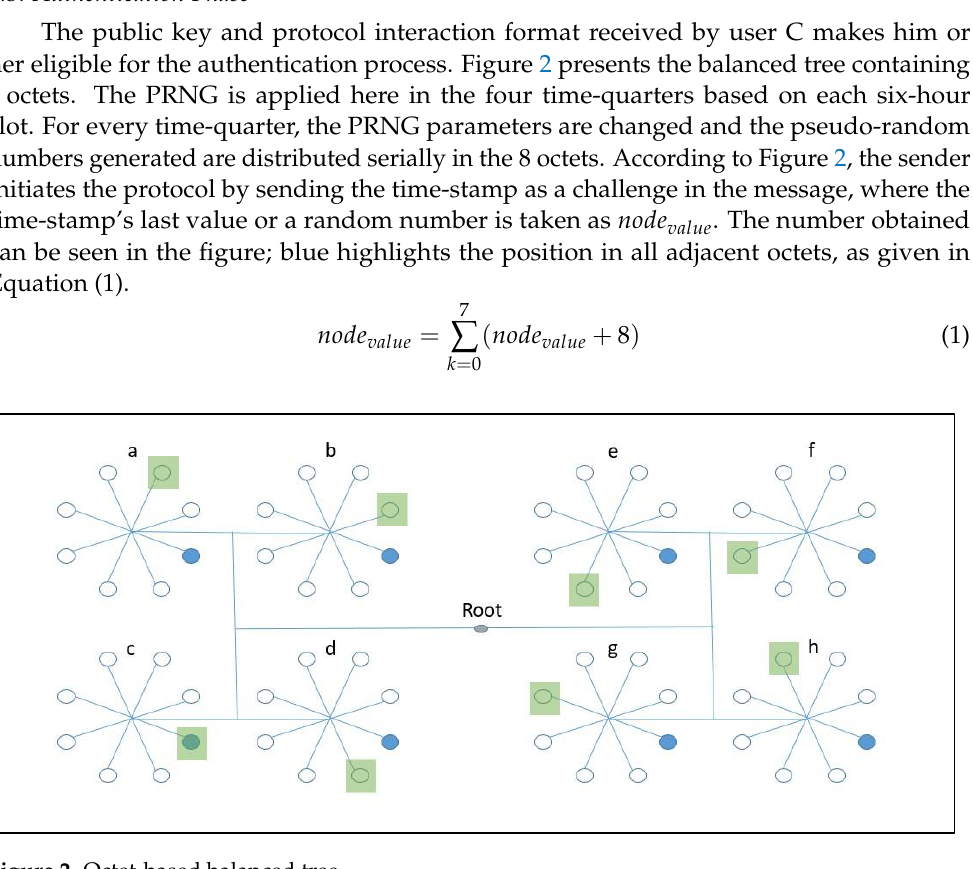
Figure 2. Octet-based balanced tree.